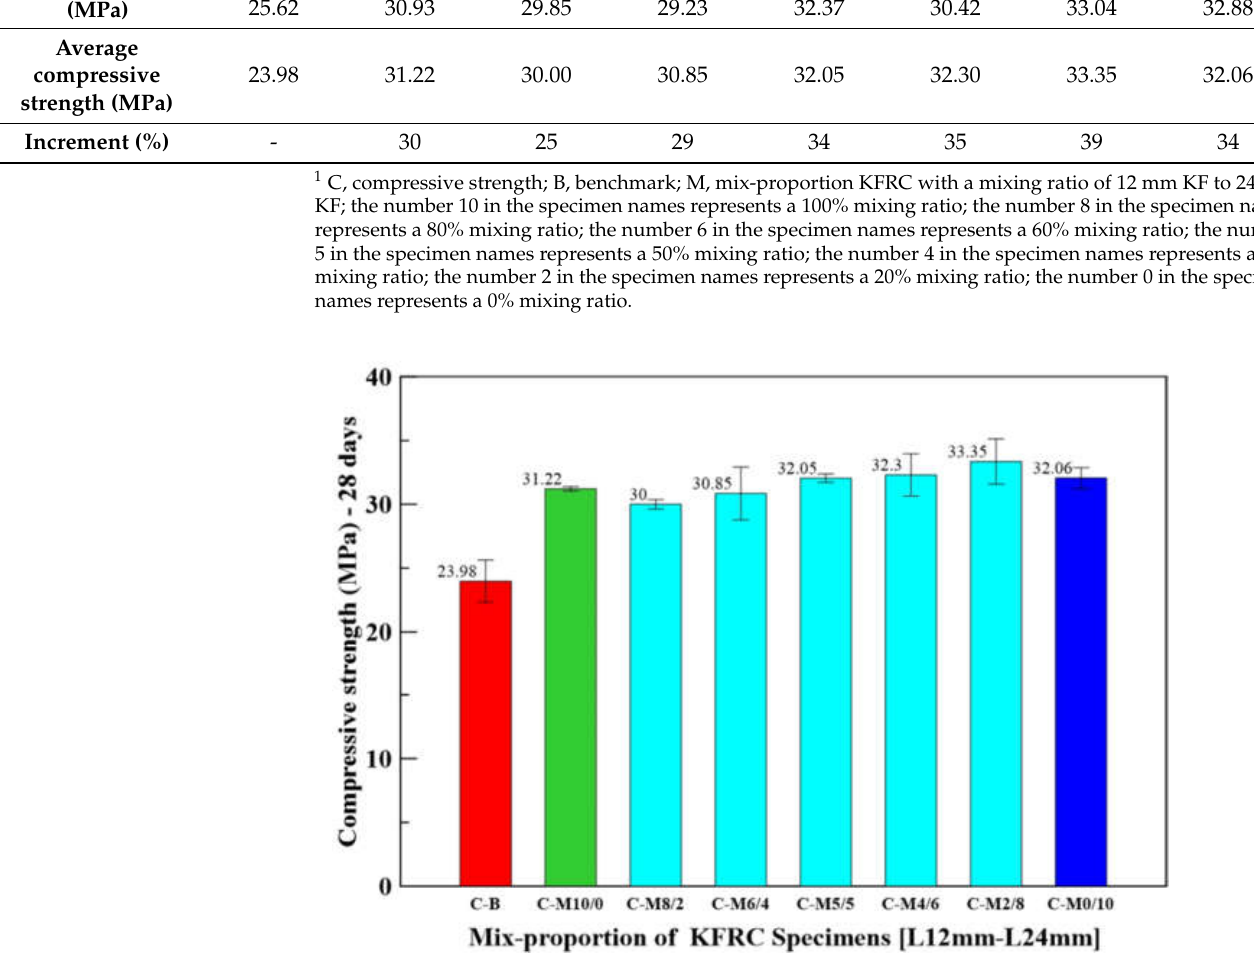
Figure 6. Compressive strengths of the benchmark and mix-proportion KFRC specimens.